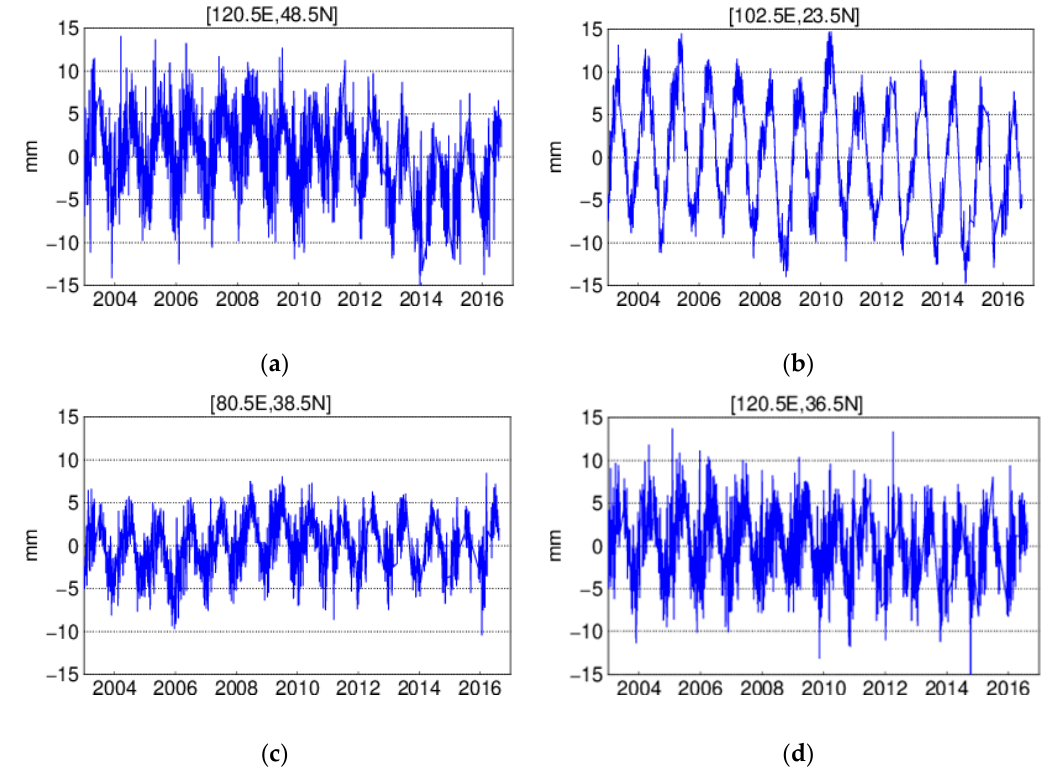
Figure 3. Vertical daily displacement derived from GRACE at four selected grids: ( a ) at grid (120.5 E, 48.5 N); ( b ) at grid (102.5 E, 23.5 N); ( c ) at grid (80.5 E, 38.5 N); ( d ) at grid (120.5 E, 36.5 N).